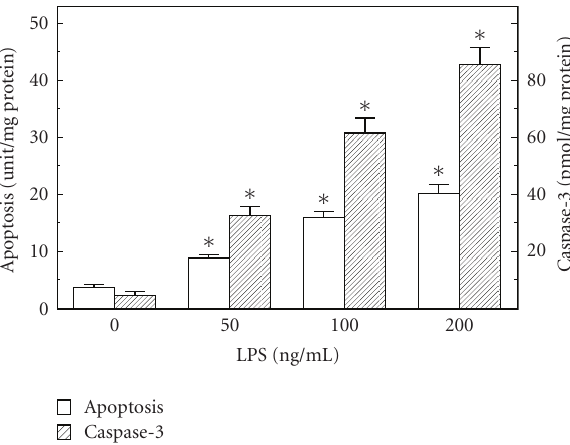
Figure 1: E ff ect of H. pylori LPS on rat gastric mucosal cell apoptosis and caspase-3 activity. The cells were treated with the indicated concentrations of the LPS and incubated for 16h. Values represent the means ± SD of five experiments. ∗ P < . 05 compared with that of control (LPS, 0).